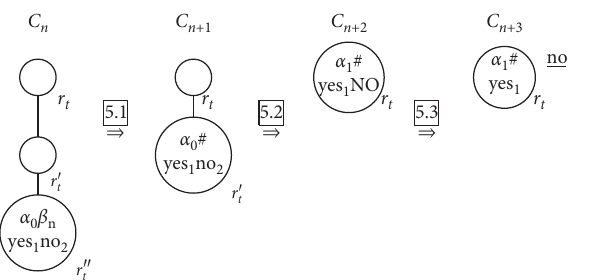
Figure 2: Negative answer. With rules from 4 and 5, an object no is sent to the environment in the last step of the computation.